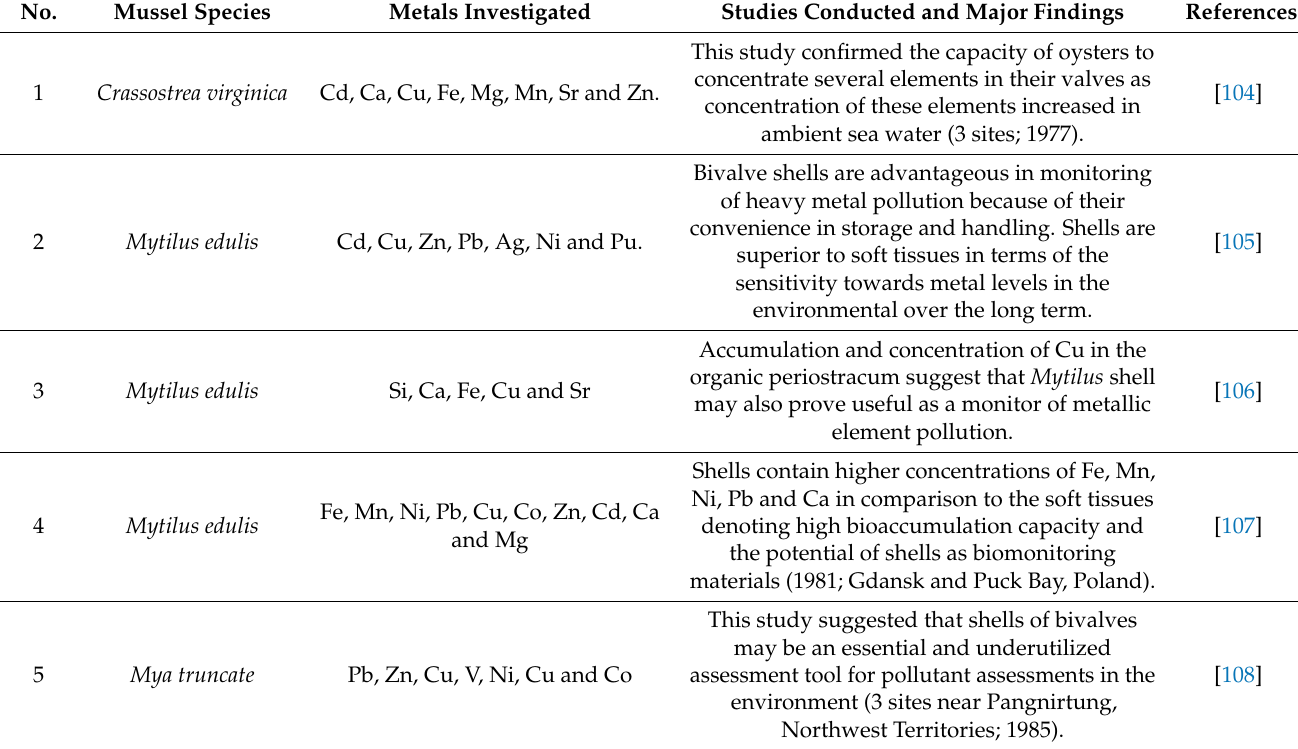
Table 2. A review on the use of shells of bivalves in metal pollution studies from some of the available literature. No. Mussel